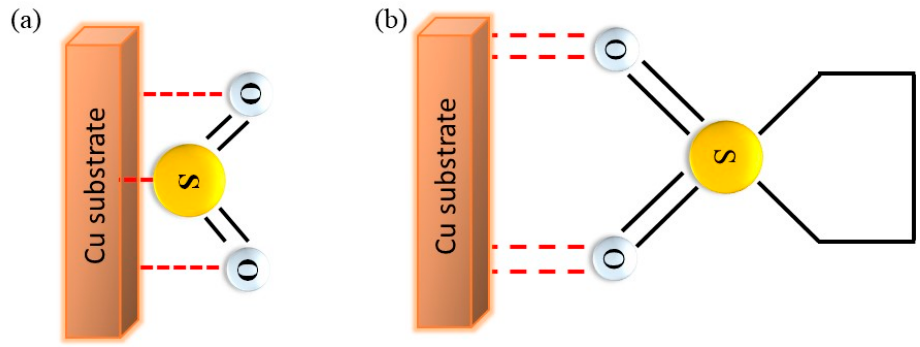
Figure 7. ( a ) Schematic representations for the interaction of ( a ) SO 2 and ( b ) sulfolane with the Cu substrate.